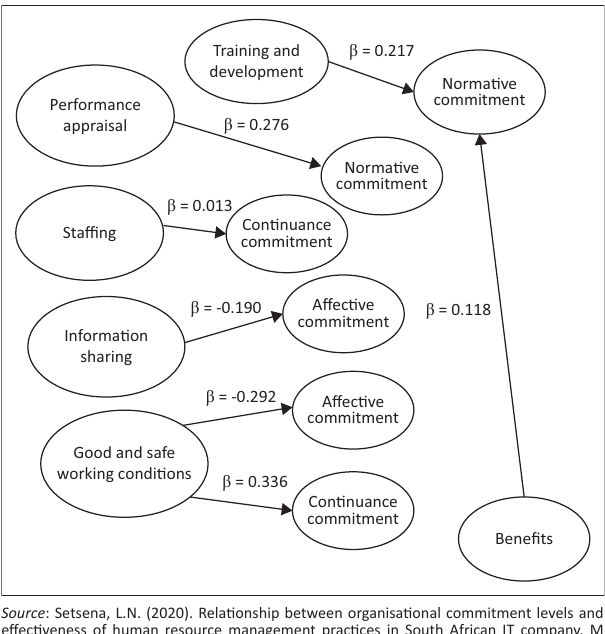
FIGURE 1: Structural model relationship between organisational commitment and human resource management